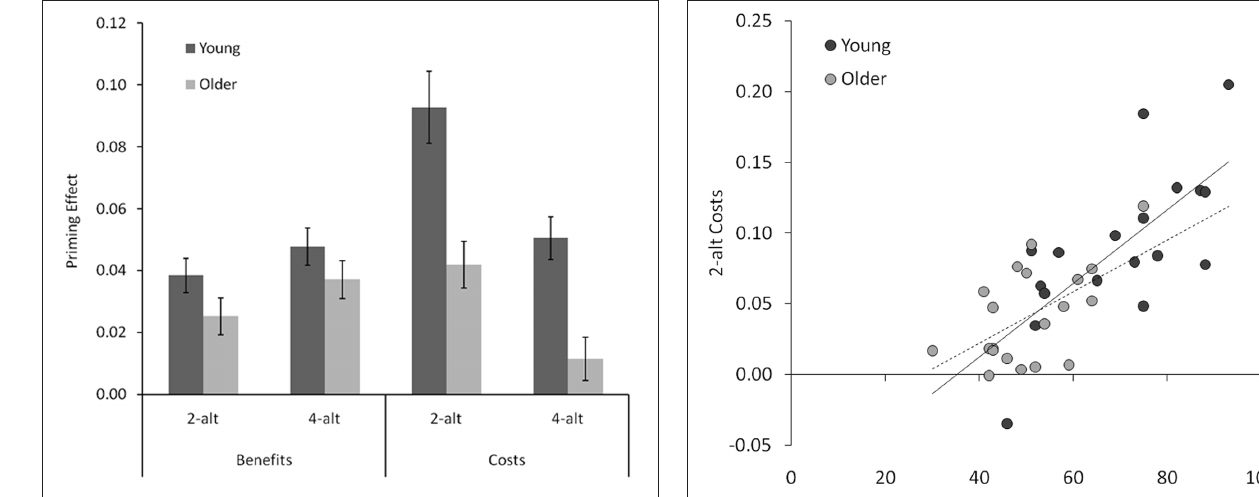
FIGURE 3 | Benefits (neutral RT : compatible RT ratio minus 1) and costs (incompatible RT : neutral RT ratio minus 1) for young and older adults in the 2-alt and 4-alt choice tasks. Error bars represent standard errors.